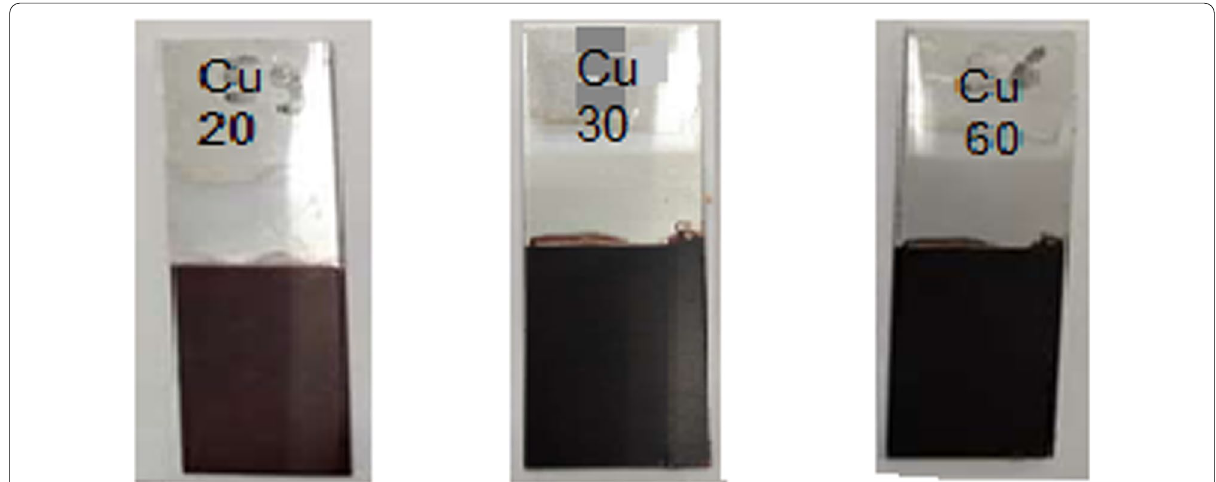
Fig. 2 Colored with Cu only using anodization time of 20, 30 and 60